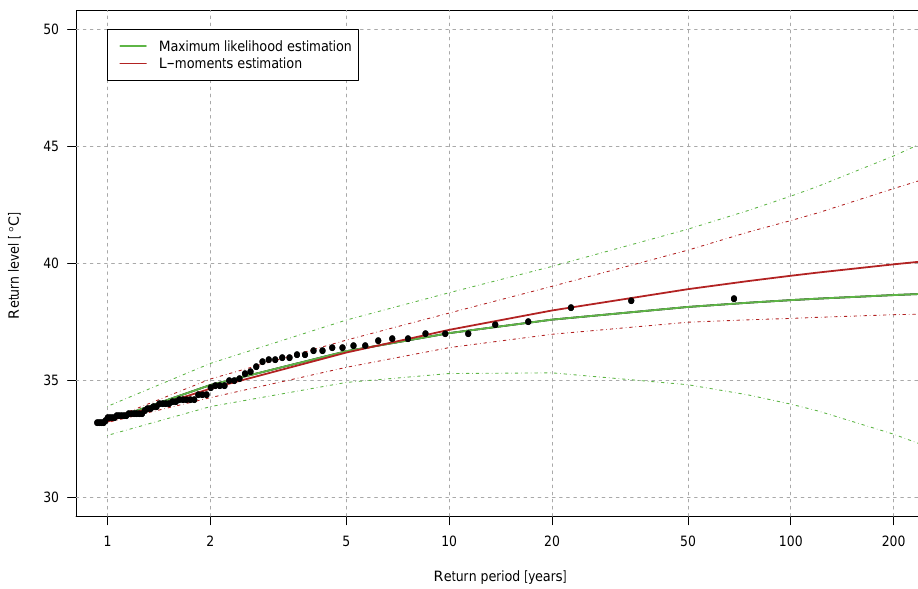
Figure 3. Return level plot of temperature maxima at Schwechat. Return level estimation is based on the threshold excess approach with two different parameter estimation methods (MLE and LMOM estimation). Solid lines show the mean estimate, while dashed lines indicate the 95% confidence intervals for the fitted